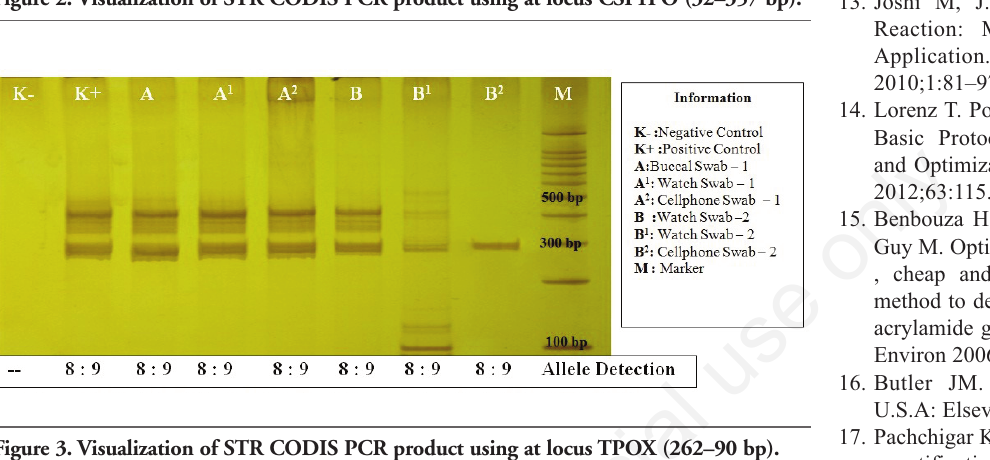
Figure 2. Visualization of STR CODIS PCR product using at locus CSF1PO (32–357 bp).